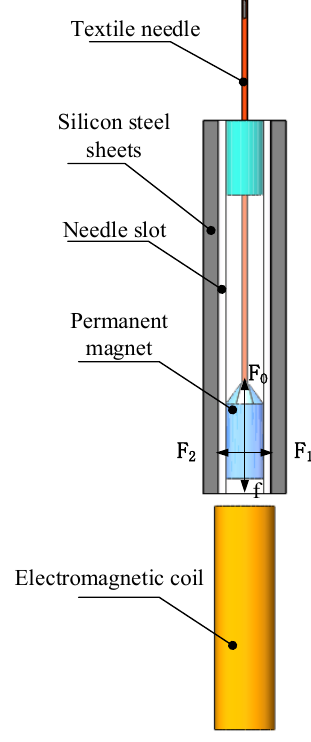
Figure 6. Needle drive structure diagram. Table 2. Parameter table of electromagnetic